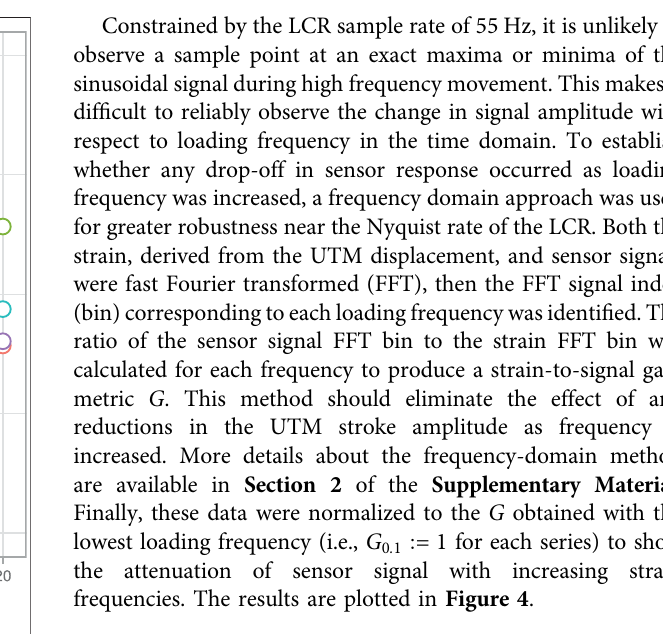
FIGURE4| Decreasingsensor response undersinusoidalstrains of0.1, 1, 10, 15, and 20 Hz; normalized to the 0.1 Hz trial.